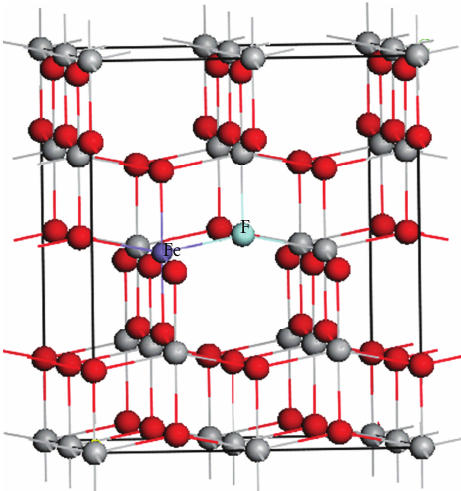
Figure 1: Structure of 48-atom anatase TiO 2 codoped with F and Fe. The gray and red spheres represent Ti and O atoms, respectively. Table 1: Formation energies E f (eV) of single-element-doped and codoped TiO 2 in di ff erent conditions. E f (eV) Ti-rich O-rich Fe-TiO 2 5.51 − 4.80 F-TiO 2 − 4.97 0.18 S-TiO 2 − 2.31 2.85 F-Fe-TiO 2 − 0.19 − 5.35 Fe-S-TiO 2 4.35 −